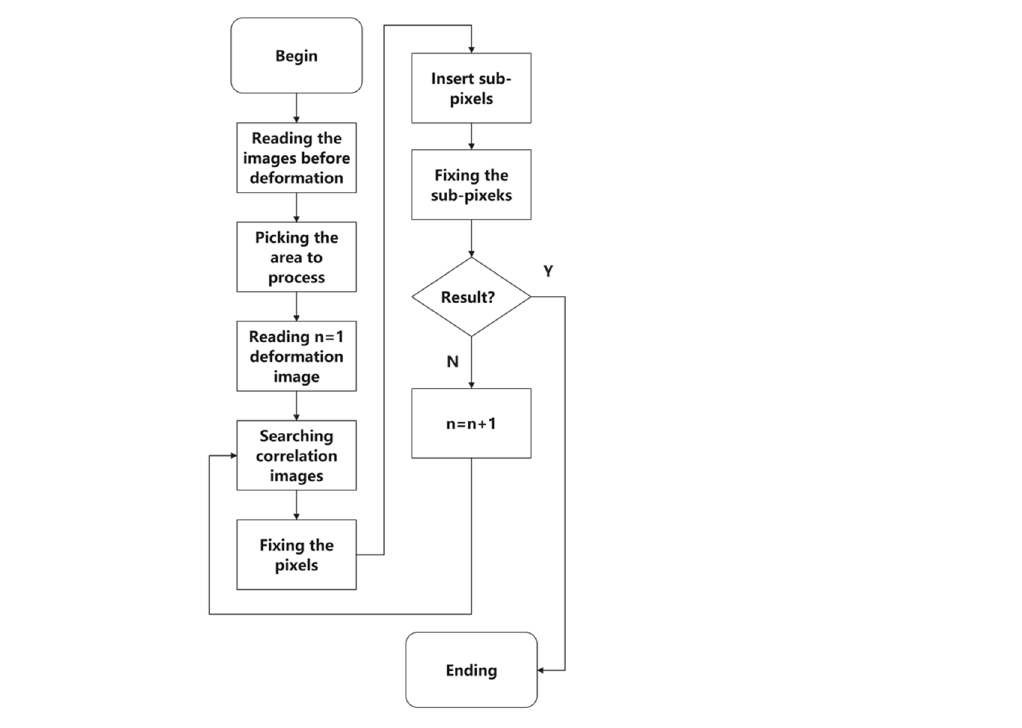
Figure A4. DIC correlation analysis flowchart.